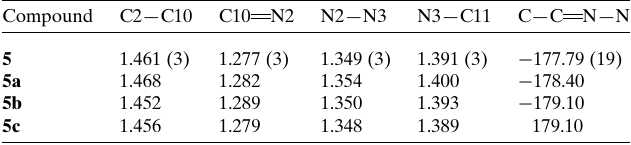
Table 2 Comparison of main bond lengths (A˚ ) and C—C N—N torsion